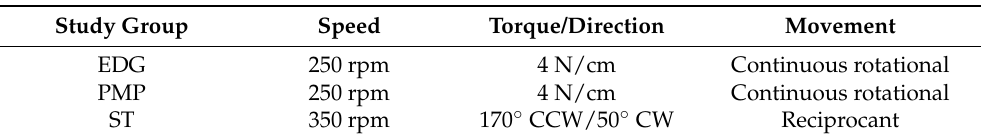
Table 1. Characteristics of the movement performed by each study group, in terms of speed, torque/direction of movement, and type of movement. Study Group Speed Torque/Direction Movement EDG 250 rpm 4 N/cm Continuous rotational PMP 250 rpm 4 N/cm Continuous rotational ST 350 rpm 170 ◦ CCW/50 ◦ CW